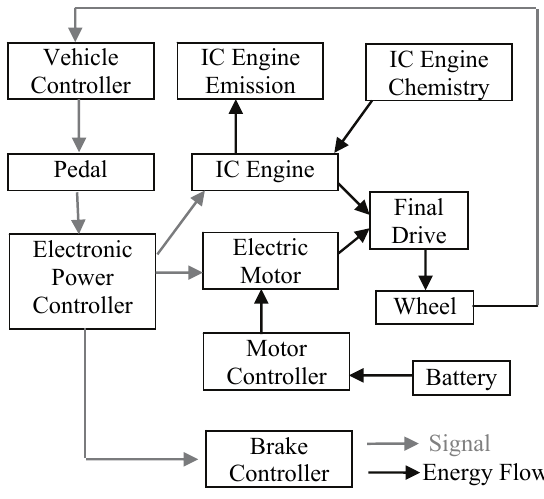
Figure 1. Block diagram of parallel PHEV.